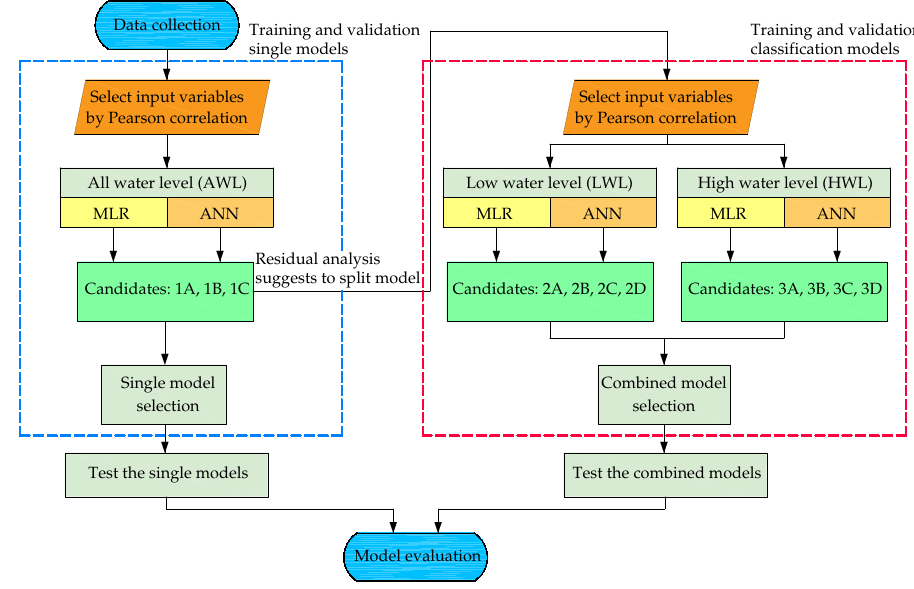
Figure 5. Workflow for the whole investigation process in this